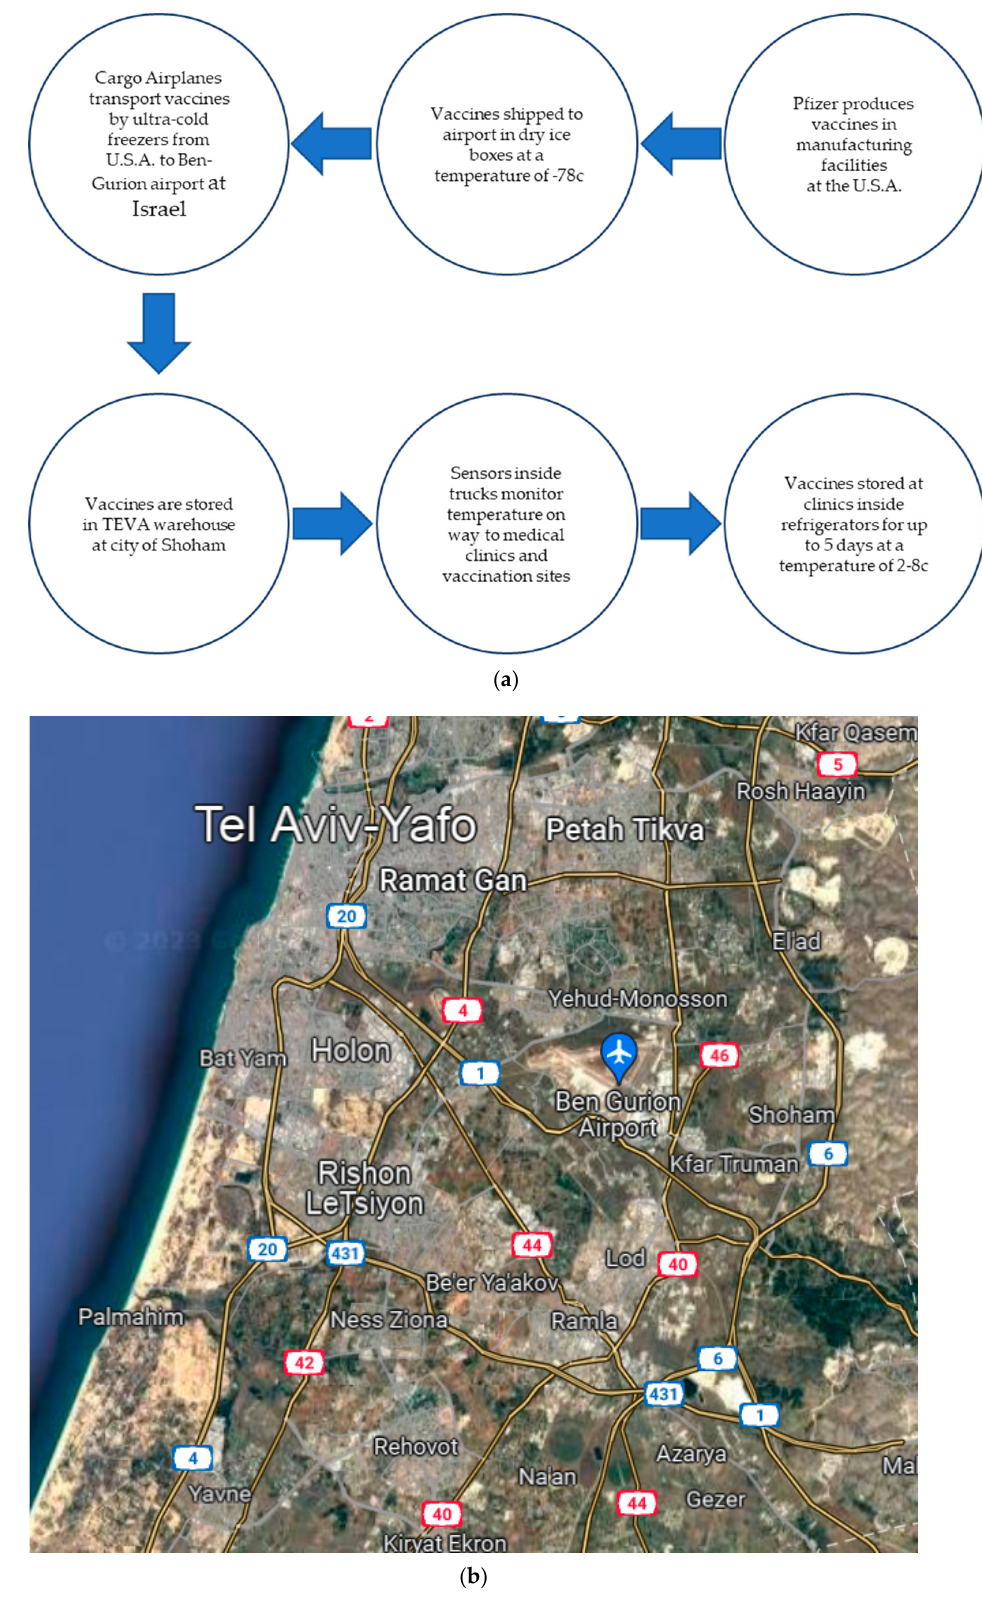
Figure 1. ( a ) The ultra-cold supply chain for the COVID-19 vaccines ( b ) Map of Israel showing Road 6, the city of Shoham, and the Ben-Gurion airport.